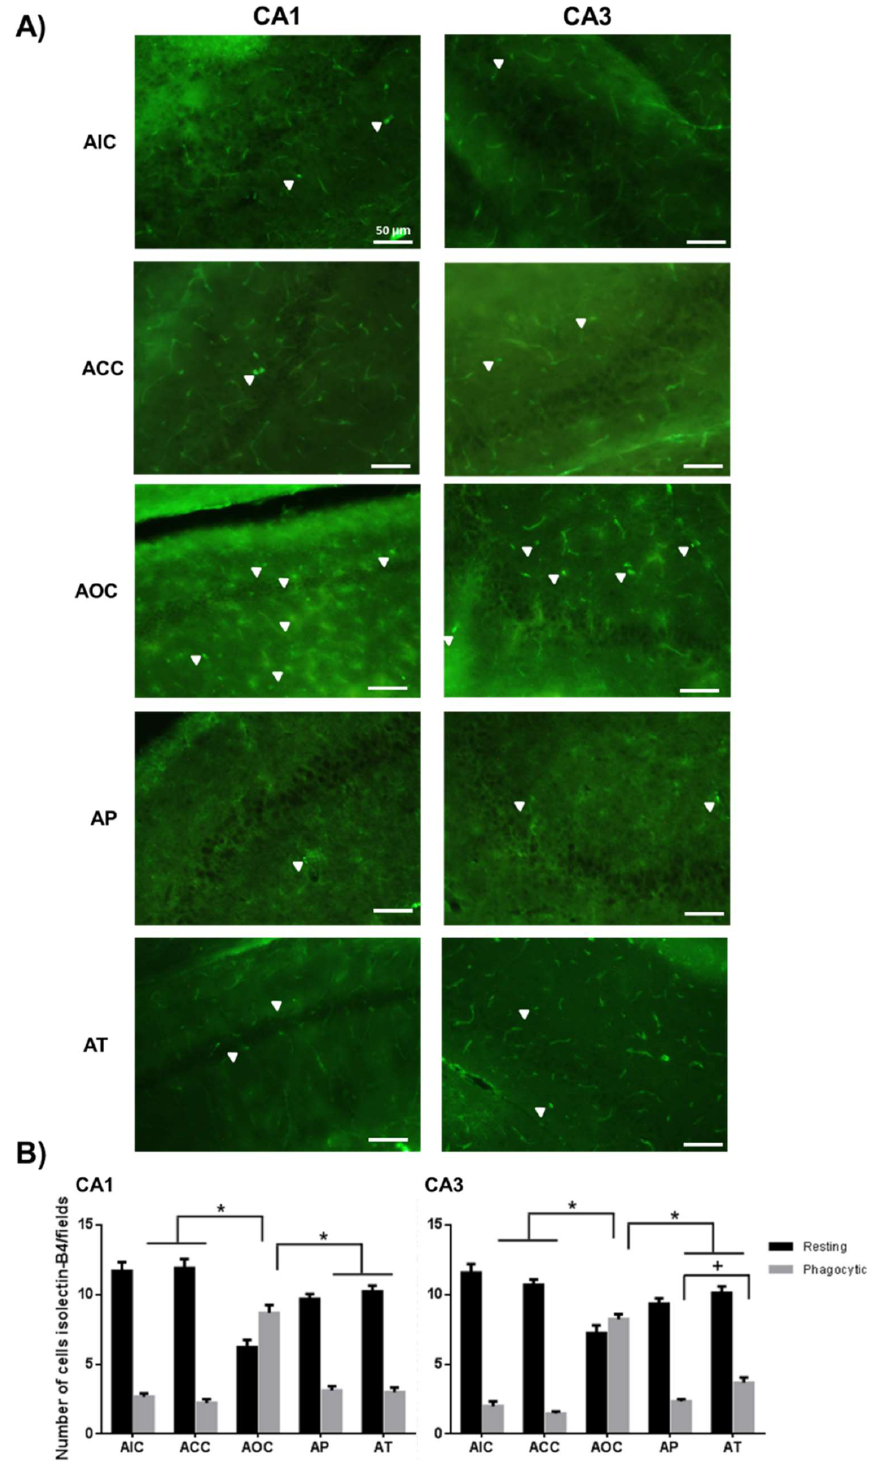
Figure 3. Effect of CUR on microglial cells in the acute exposure to O 3 . ( A ) Representative fluorescent photomicrographs show isolectin-B4 reactivity in the CA1 and CA3 regions of the rat hippocampus. The AP and the AT groups showed a significant decrease in the number of activated microglia. Scale bars 50 µ m. ( B ) The total number of isolectin-B4 positive cells are shown in the graph as mean ± SEM and classified according to their morphology. * p < 0.001, + p < 0.01.